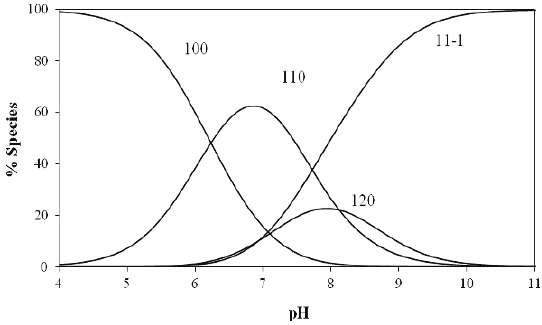
Figure 1. Concentration distribution diagram of Zn(II)-1- aminocylclopropane carboxylic acid complexes at 25 o